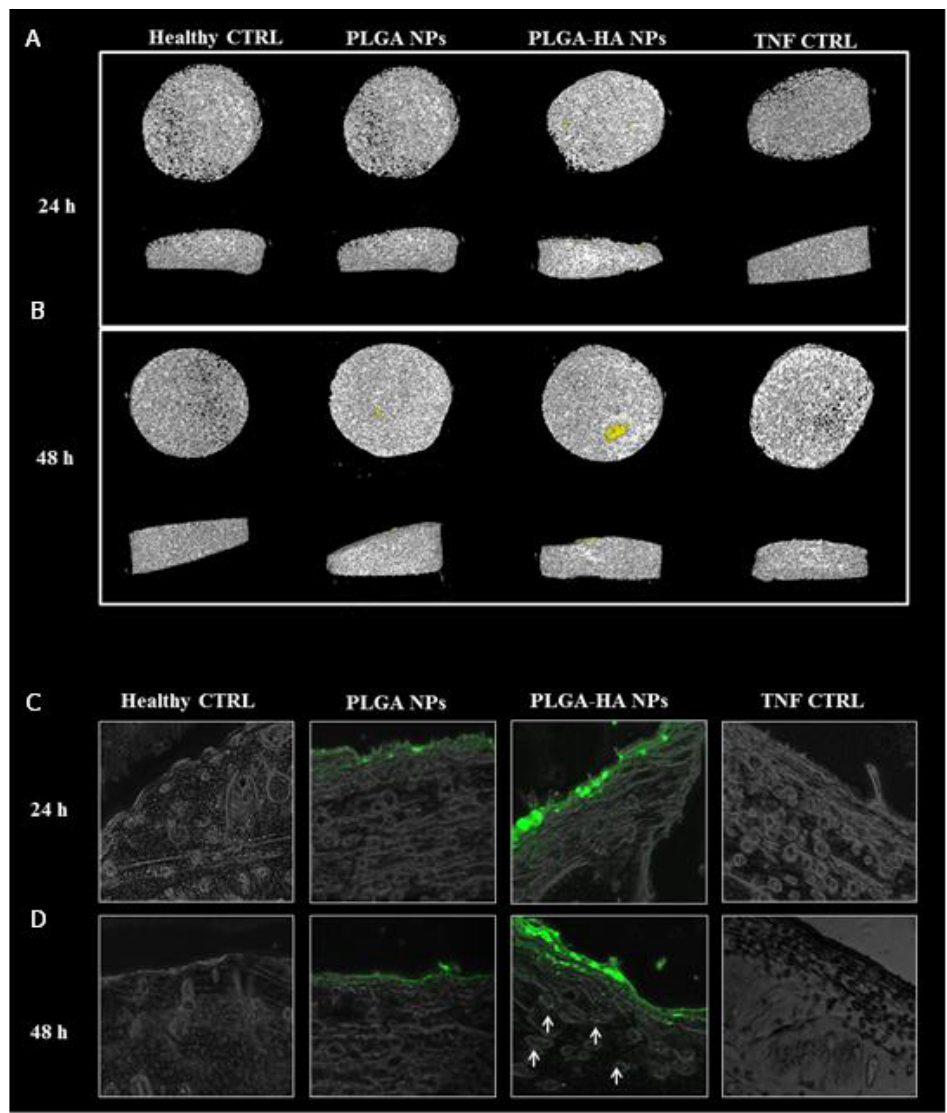
Figure 8. Human cartilage explant incubated with NPs. ( A ) µCT scan of human cartilage and NPs after 24 h of incubation. ( B ) µCT scan of human cartilage and NPs after 48 h of incubation. ( C ) Fluorescent images of human cartilage and NPs after 24 h of incubation at 37 °C. ( D ) Fluorescent images of human cartilage and NPs after 48 h of incubation. ( A – D ) From left to right, healthy cartilage (with no TNF treatment), cartilage incubated with TNF and PLGA NPs, cartilage incubated with TNF and PLGA-HA NPs, and cartilage treated with TNF only.